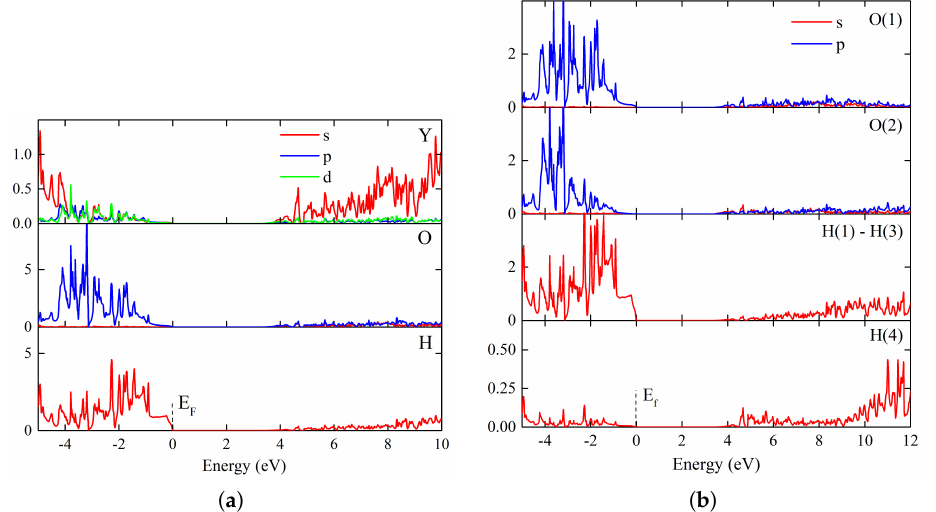
Figure 7. Electron structure of Y 2 H 3 O(OH) in terms of density of states (DOS):: The Fermi level is shifted to a zero value. The highest valence band state and the lowest conduction band state at the Brillouin zone center determine the fundamental band-gap width of 3.4 eV. ( a ) Element-projected partial density of states. ( b ) Site-projected partial density of states. H(1)–H(3) positions relate to the hydride anion; H(4) describes the proton in the hydroxide